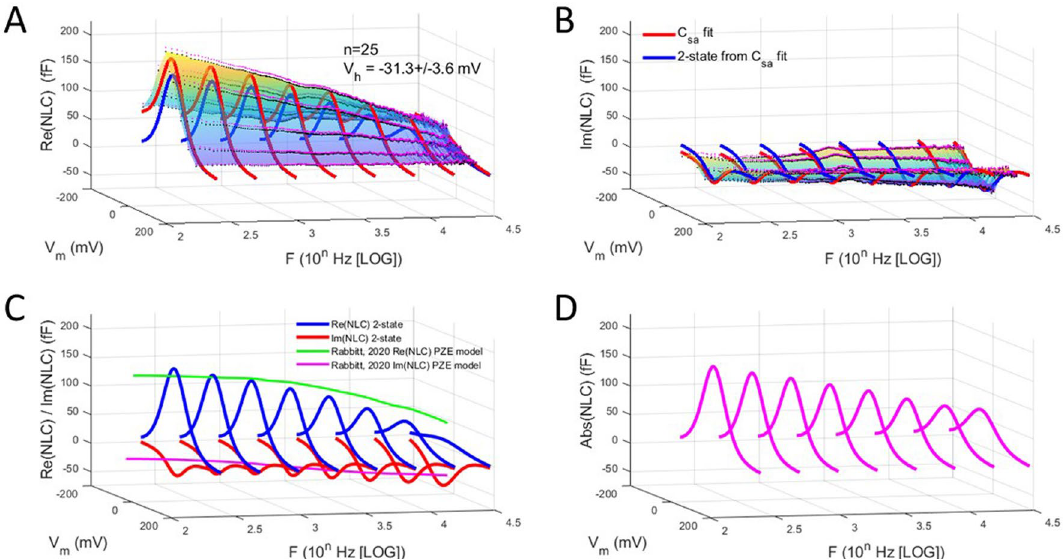
Figure 1. Real and imaginary components of patch NLC. (A) Real component of complex NLC across interrogating frequency. Note continuous decrease as frequency increases. Fits are made to Eq. (1) to extract the 2-state (blue line) response at selected frequencies. V h is average between 0.244 and 2.44 kHz. (B) Imaginary component of complex NLC. In this case, magnitude increases with frequency, but there is not a full reciprocal trade-off with the real component. (C) Plot of the 2-state fits across frequency. Superimposed is the PZE model response at V h of Rabbitt (2020), which shows general agreement within this bandwidth. (D) Plot of the absolute Re ( NLC ) 2 + Im ( NLC ) 2 , indicating a continuous reduction of prestin activity magnitude of NLC, namely, (cid:31) across